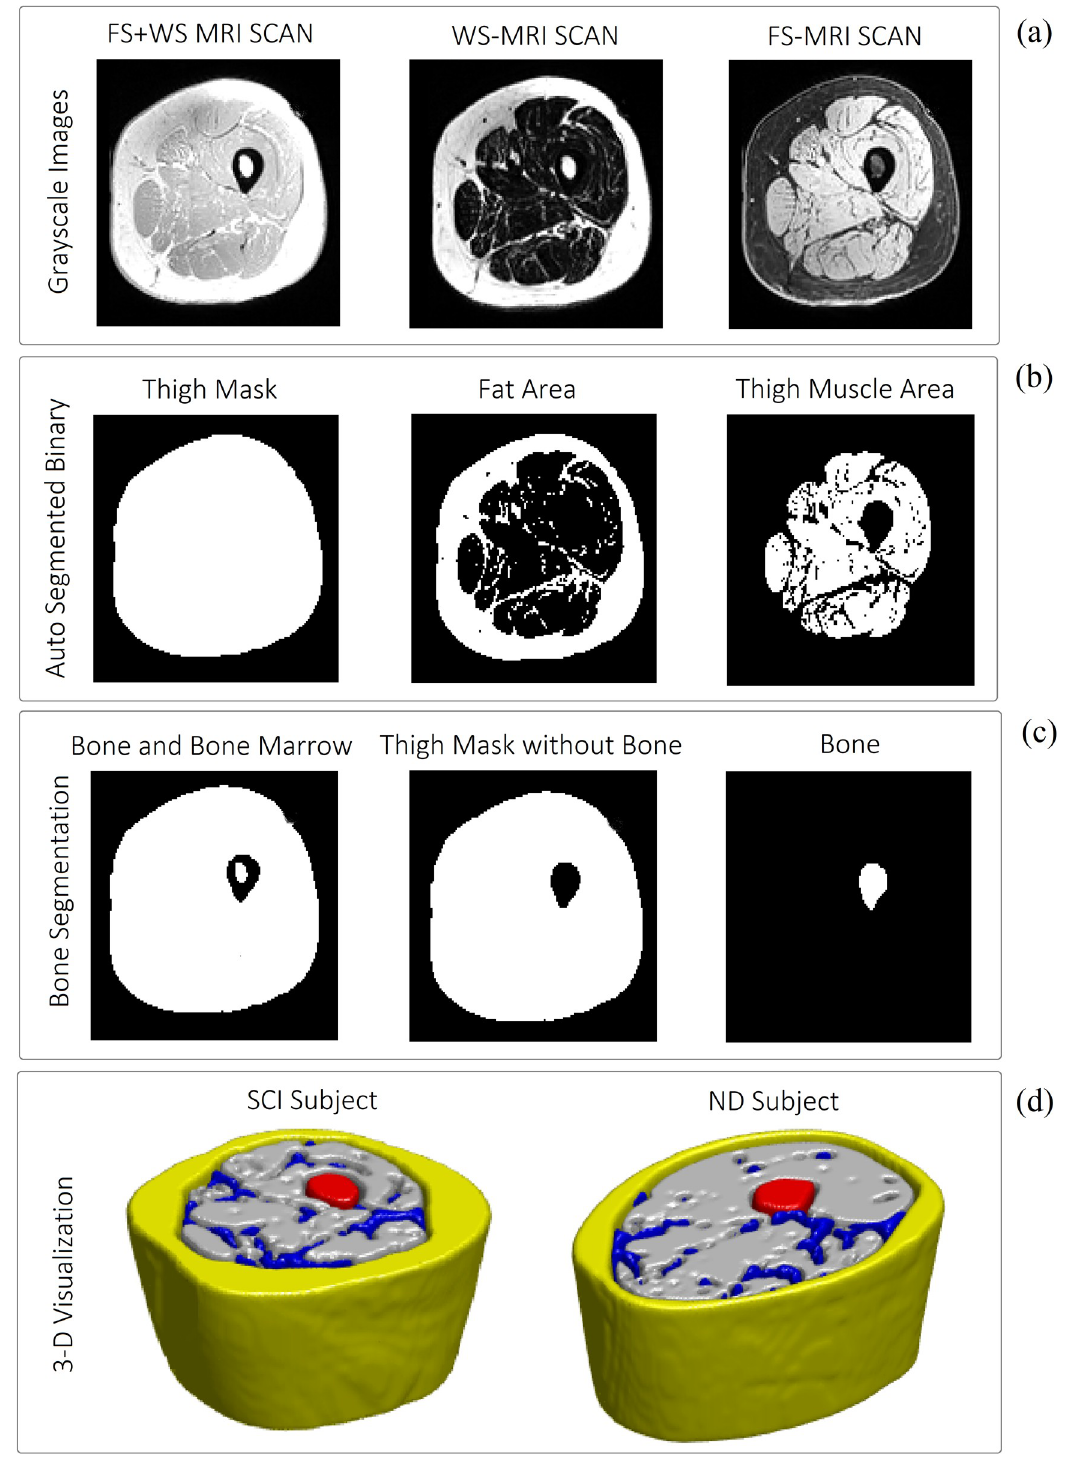
Fig 4. Examples for the utilization of LCDG to segment the soft tissue volumes. (a) From left to right: gray scale MR images for FS+WS, WS and FS; (b) From left to right: binary mask of total thigh area, total fat and total muscle area; (c) From left to right: steps for segmenting the bone and bone marrow; (d) 3-D representations of the segmentation results for SCI (left) and ND (right) thigh; Grey: Muscle area, Yellow: SAT, Blue: IMAT, Red: bone.